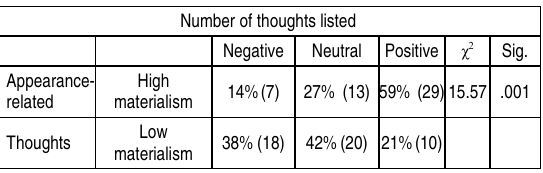
Table 8A. Chi-square analysis for toothpaste advertisement